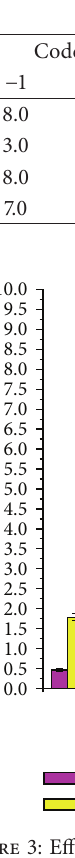
Table 4: Production variables and their coded and actual values used for optimization of rifamycin B production from mediterranei MTCC 14 by using central composite design.